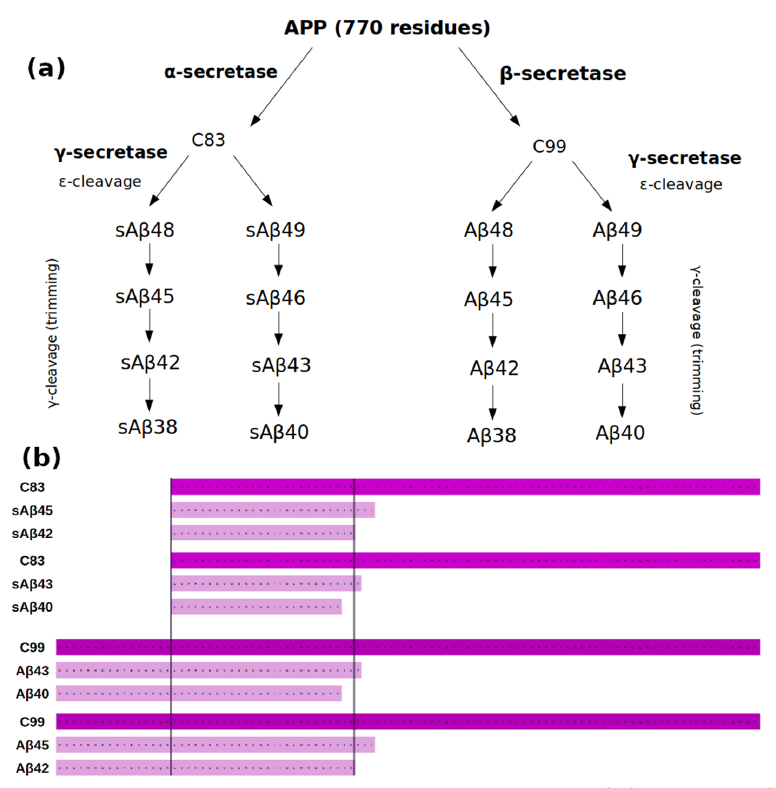
Figure 1. ( a ) The nonamyloidogenic (after α -secretase cleavage) and amyloidogenic (after β -secretase cleavage) pathways of amyloid precursor protein (APP); ( b ) the sequence multiple alignment of selected substrates and products of APP. At the bottom of the figure, the Aβ 42 sequence is shown, including the sAβ 42 sequence marked in violet.